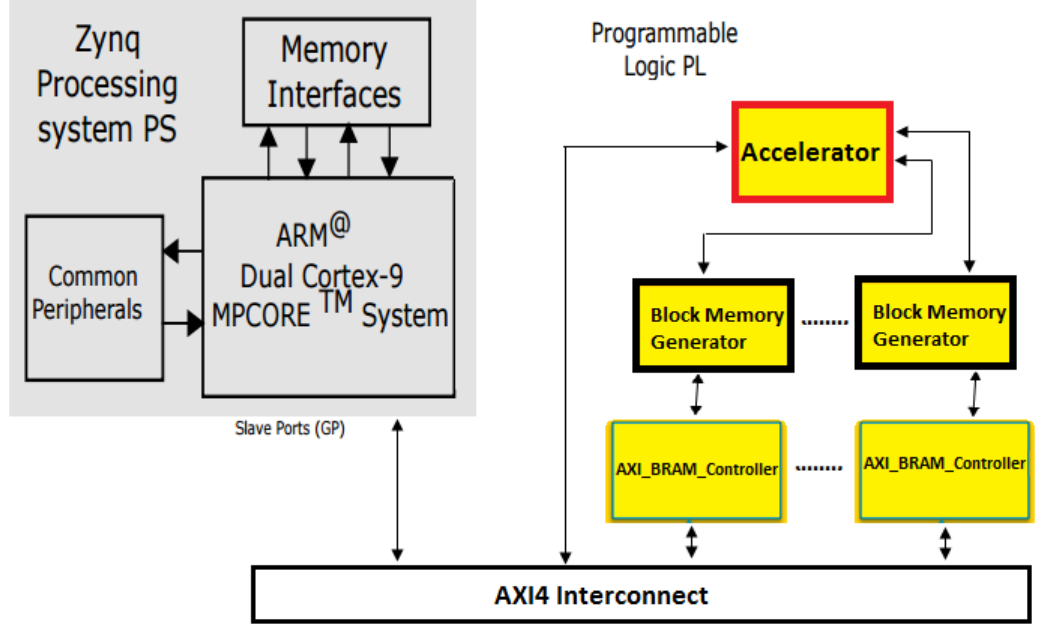
Figure 24. Architecture of Zynq processor and BRAM